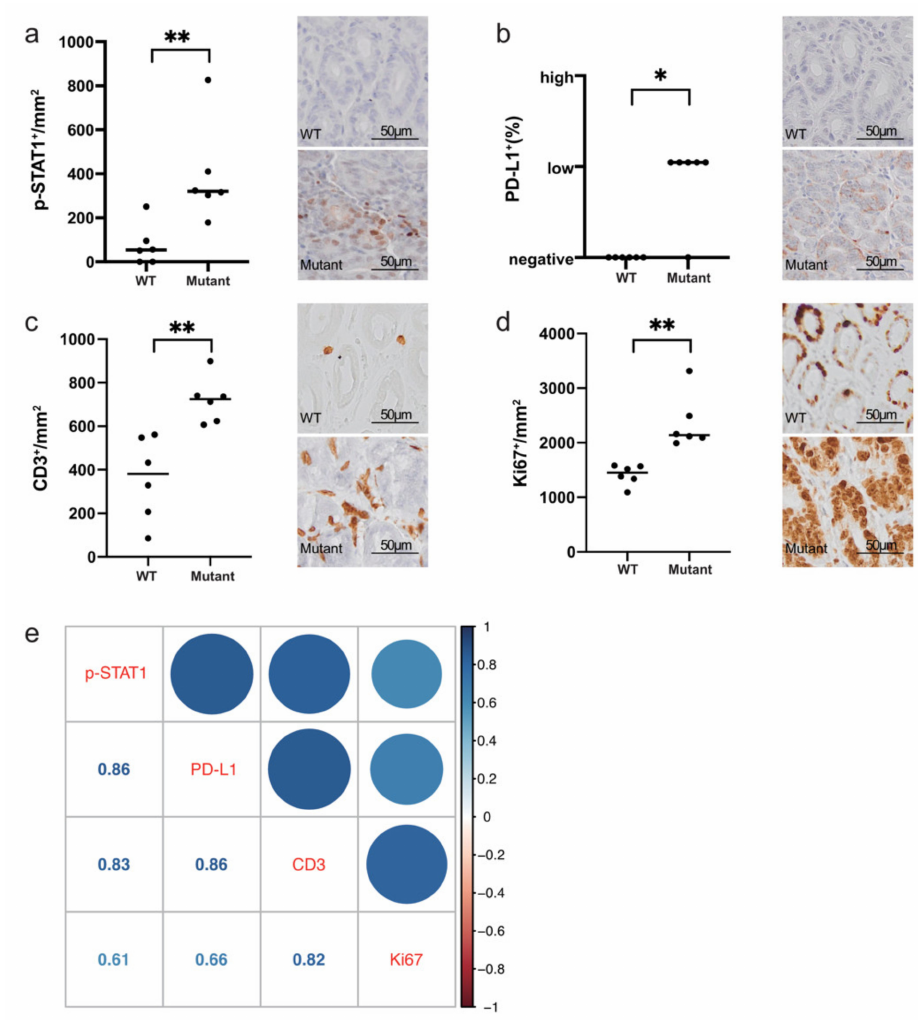
Figure 2. Immunohistochemistry staining of p-STAT1, PD-L1, immune infiltration, and proliferation in H. pylori -induced gastric lesions of Rnf43 mutant mice (20 × magnification). ( a ) p-STAT1, ( b ) PD-L1, ( c ) CD3, ( d ) Ki67 in the stomachs of wild-type ( n = 6) and Rnf43 mutant mice ( n = 6) after 6-month H. pylori infection. ( e ) Correlation of gene expressions with immune infiltration and proliferation. Color represents spearman’s correlation coefficient. Wilcoxon rank-sum test, * p < 0.05, ** p < 0.01. PD-L1 staining evaluation: <1%, negative; 1–49% low; ≥ 50% high. Mutant, Rnf43 H292R/H295R mutant mice; WT, wild-type